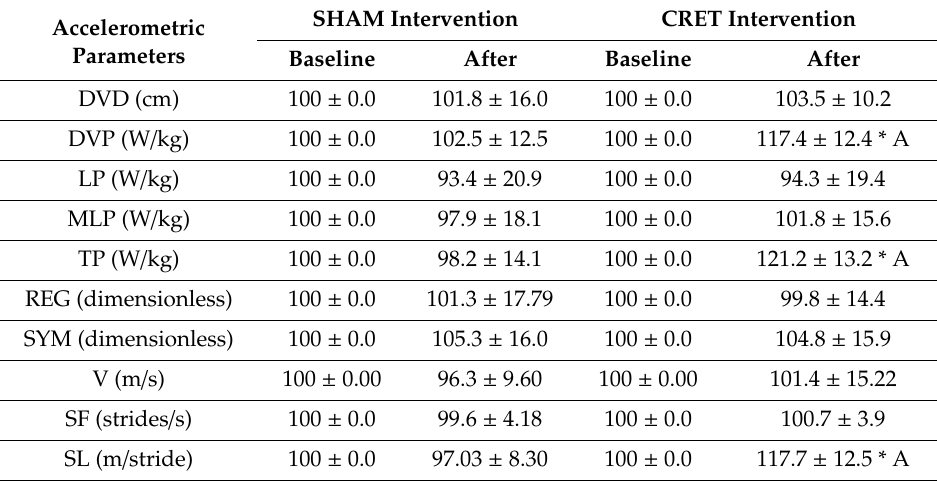
Table 6. Mean values of the accelerometric parameters measured at trot and with the accelerometer fixed at the sternum region, before and after the intervention (SHAM group and capacitive resistive electric transfer therapy group (CRET)). Data are expressed as the mean percentage ± SD, relative to baseline